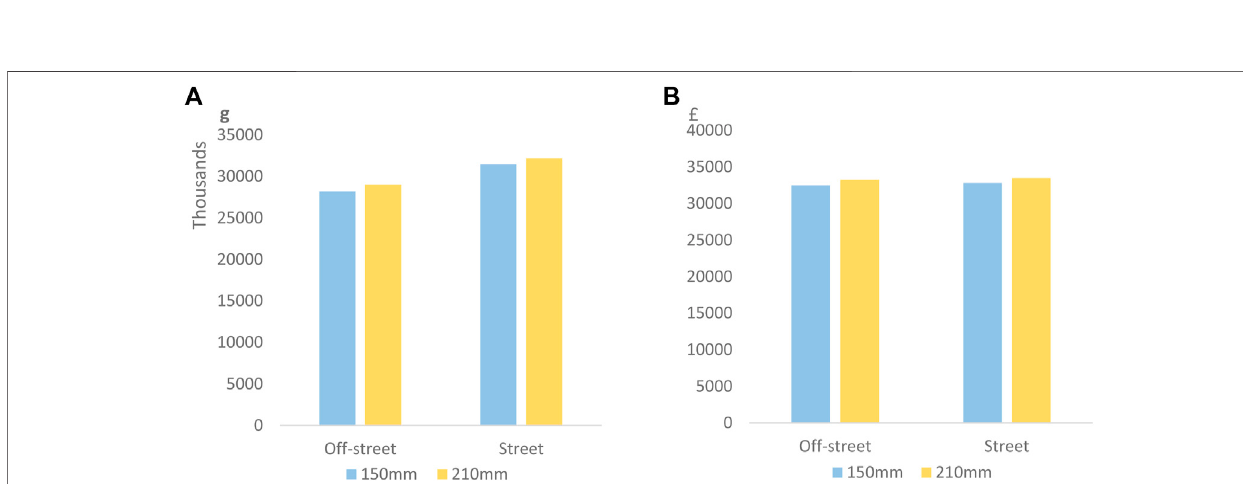
FIGURE 15 | Parametric study of light rail subbase: CO 2 emissions (A) and costs (B) .